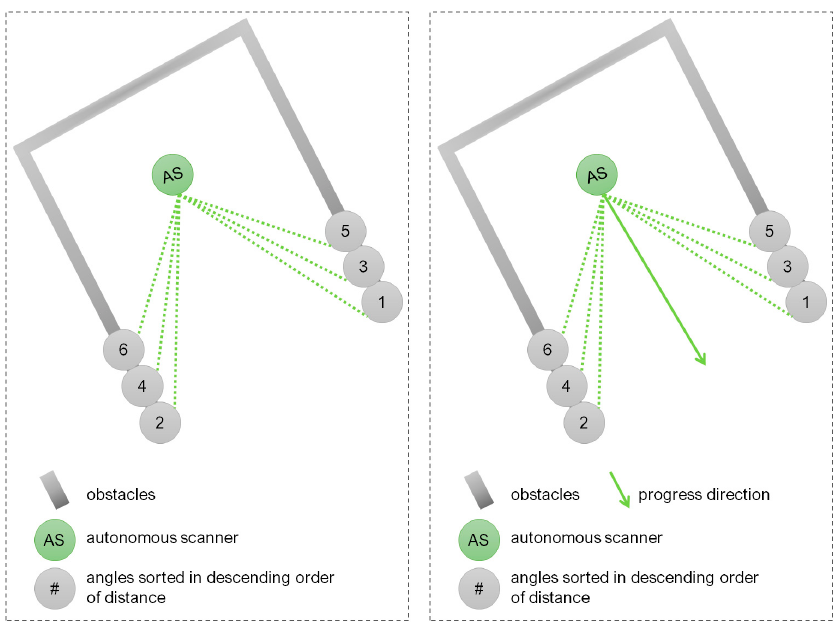
Figure 3. Derivation of direction for next destination in proposed autonomous driving algorithm.